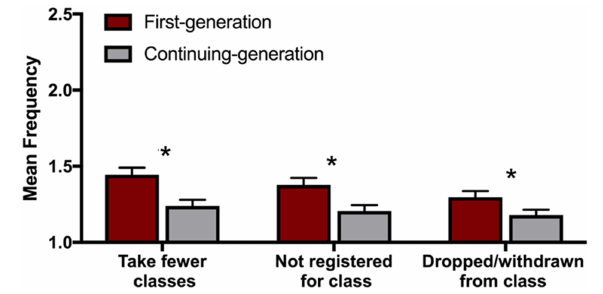
FIGURE 1 | Self-reports of behaviors engaged in because of high textbook costs, by first-generation status. Bars depict means, error bars represent standard errors of the mean, *indicates p <